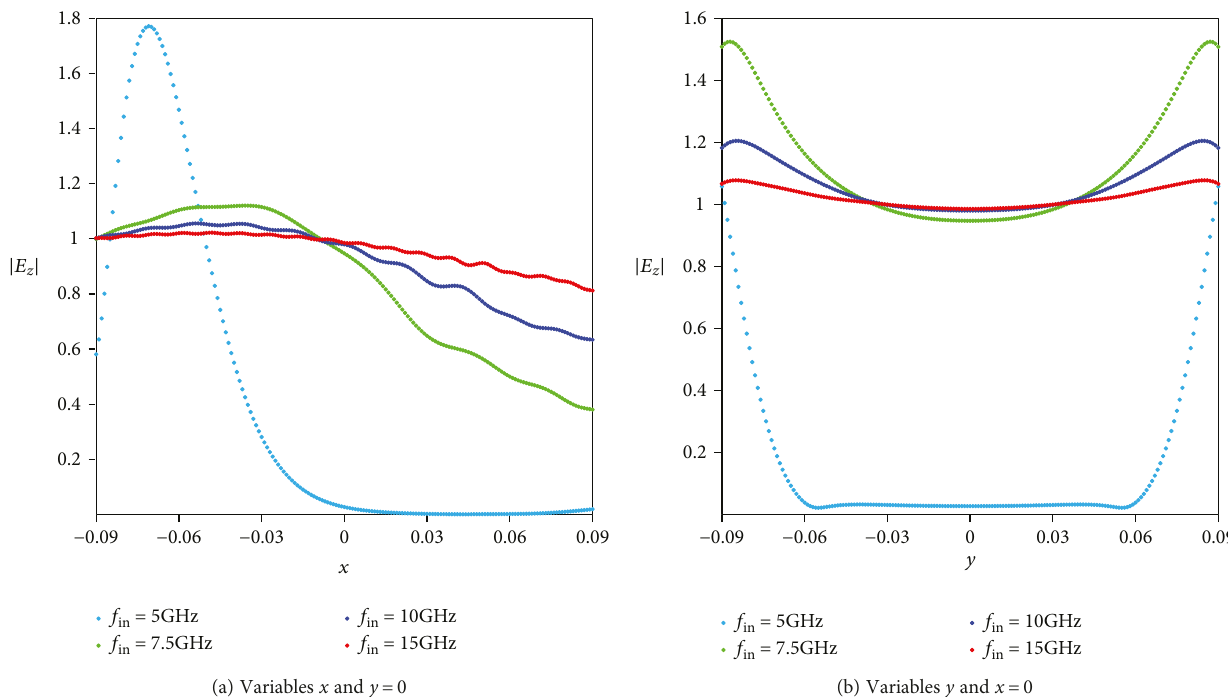
Figure 17: Magnitude of the electric fi eld, in volts/meter, inside the plasma for linear cuts through the cylinder obtained by the FDTD simulation for di ff erent incident frequencies. Central electron density is set to n ν =500 × 10 6 Hz.